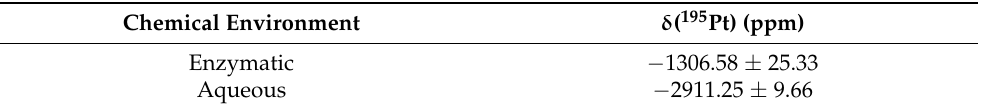
Table 1. Theoretical 195 Pt chemical shifts in different chemical environments performed at theory level PBEPBE/NMR-DKH.